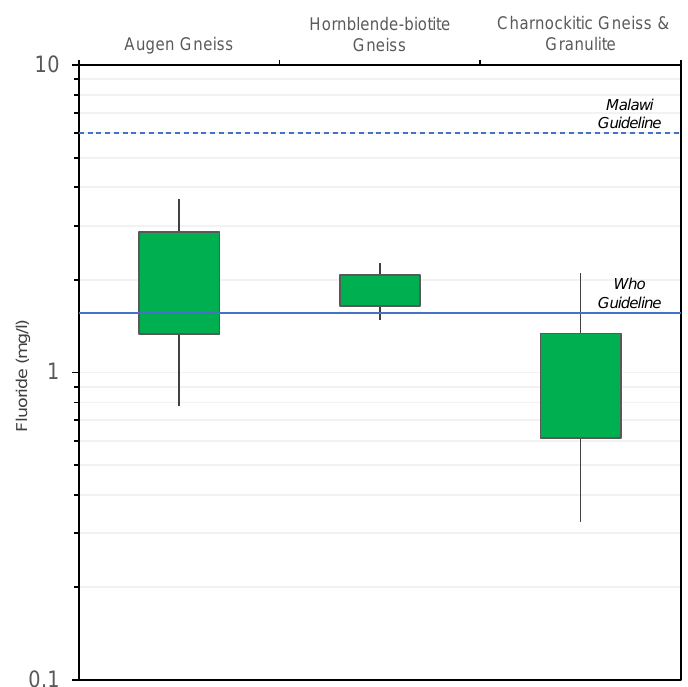
Figure 8. Box and whisker plot of fluoride concentrations (5th, 25th, 75th and 95th percentiles) in the various lithological units (augen gneiss ( n = 16), hornblende—biotite Gneiss ( n = 3) and charnockitic gneiss and granulite ( n = 20)).